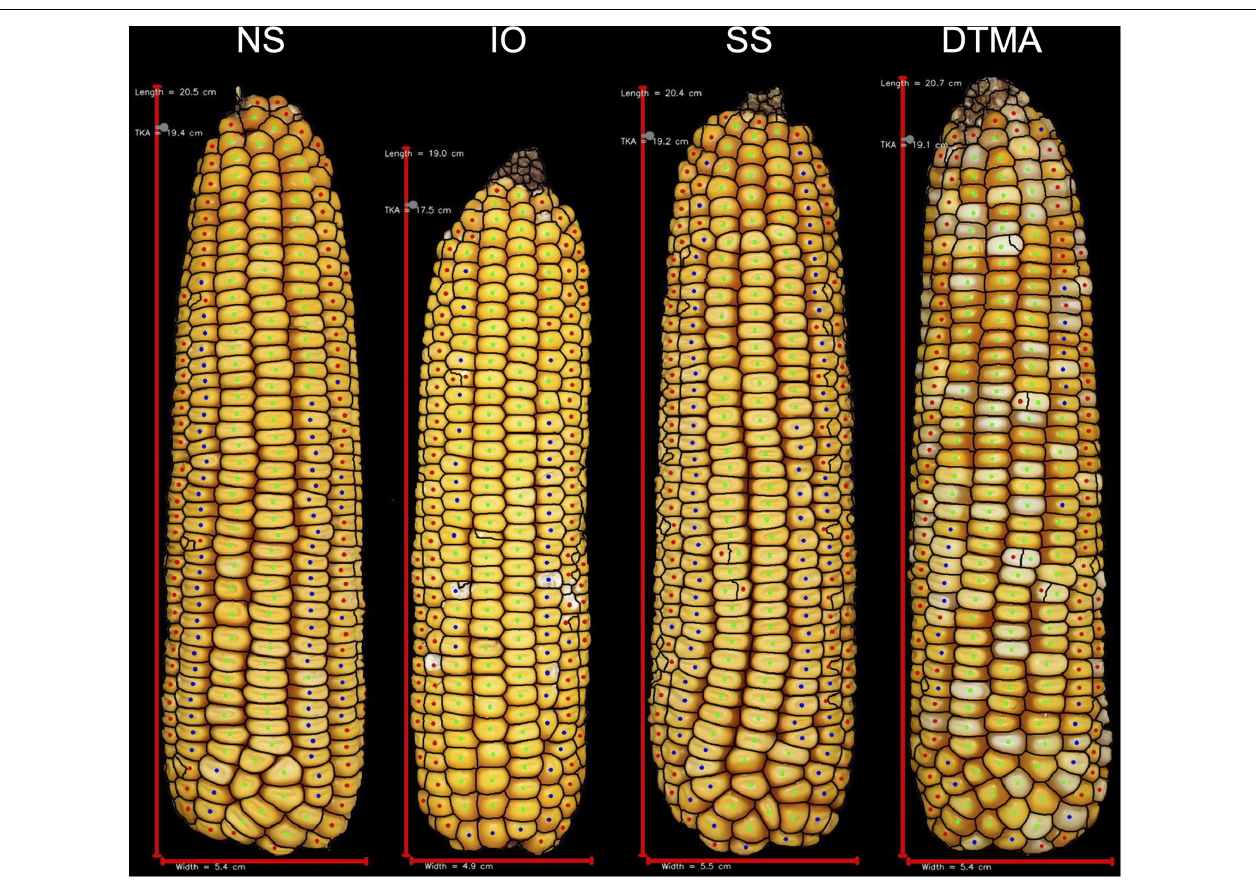
FIGURE 5 | Representative ears for each of the heterotic groups in hybrid combination with PHP02. Selected ears had an average yield and yield components for their heterotic group combination. Abbreviations for heterotic groups include: NS (Non-Stiff Stalk), IO (Iodent), SS (Stiff Stalk), and DTMA (Drought Tolerant Maize for